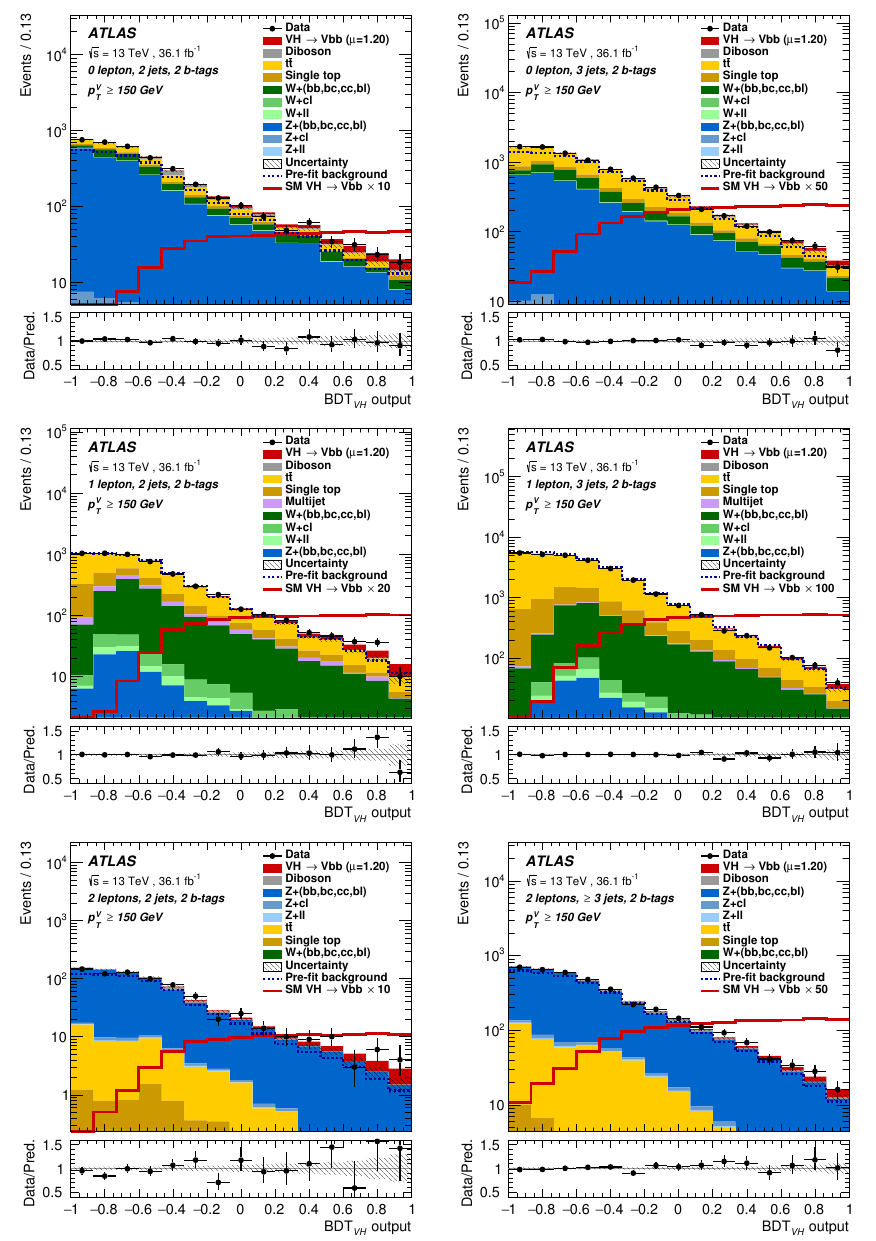
Figure 3 . The BDT V H output post-(cid:12)t distributions in the 0-lepton (top), 1-lepton (middle) and 2-lepton (bottom) channel for 2- b -tag events, in the 2-jet (left) and exactly 3-jet (or (cid:21) 3 jets for the 2-lepton case) (right) categories in the high p V region. The background contributions after T the global likelihood (cid:12)t are shown as (cid:12)lled histograms. The Higgs boson signal ( m H = 125 GeV) is shown as a (cid:12)lled histogram on top of the (cid:12)tted backgrounds normalised to the signal yield extracted from data ( (cid:22) = 1 : 20), and unstacked as an un(cid:12)lled histogram, scaled by the factor indicated in the legend. The dashed histogram shows the total background as expected from the pre-(cid:12)t MC simulation. The size of the combined statistical and systematic uncertainty for the sum of the (cid:12)tted signal and background is indicated by the hatched band. The ratio of the data to the sum of the (cid:12)tted signal and background is shown in the lower panel. The BDT V H output distributions are shown with the choice of binning used to de(cid:12)ne the global likelihood